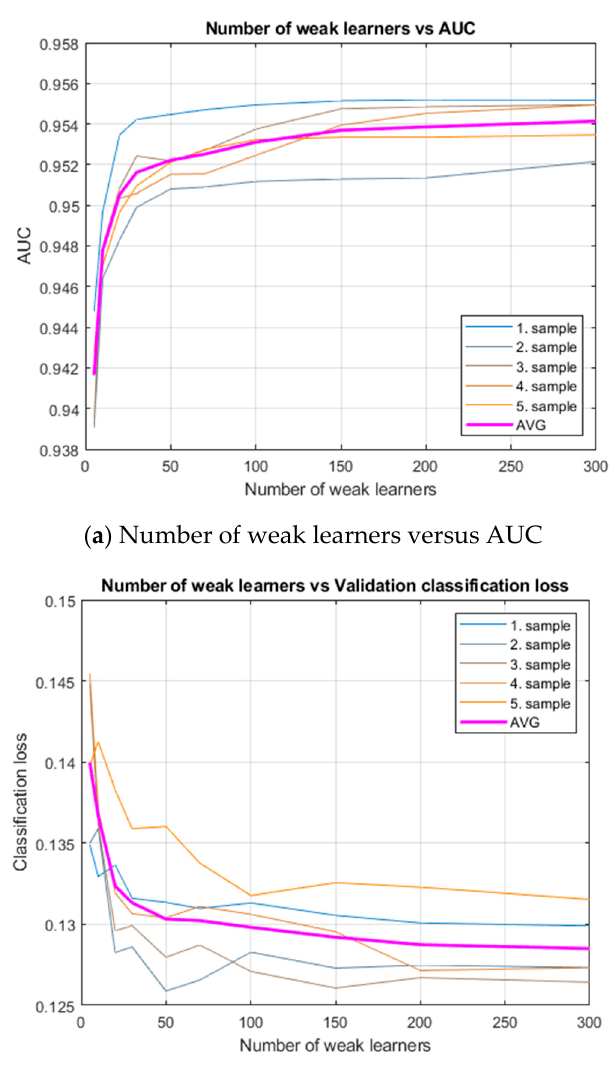
Figure 2. Summary of iteration of the number of weak learners’ parameter versus the performance metrics and classification